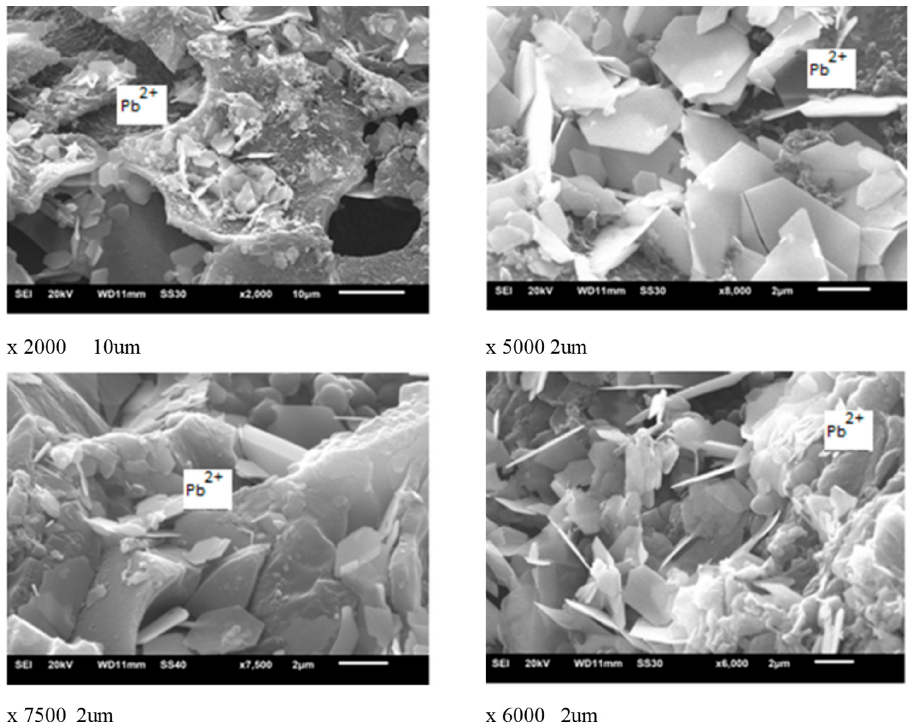
Figure 10. SEM image of Ac-Hc—Pb 2+ loaded (lamellar and hexagonal sheets).